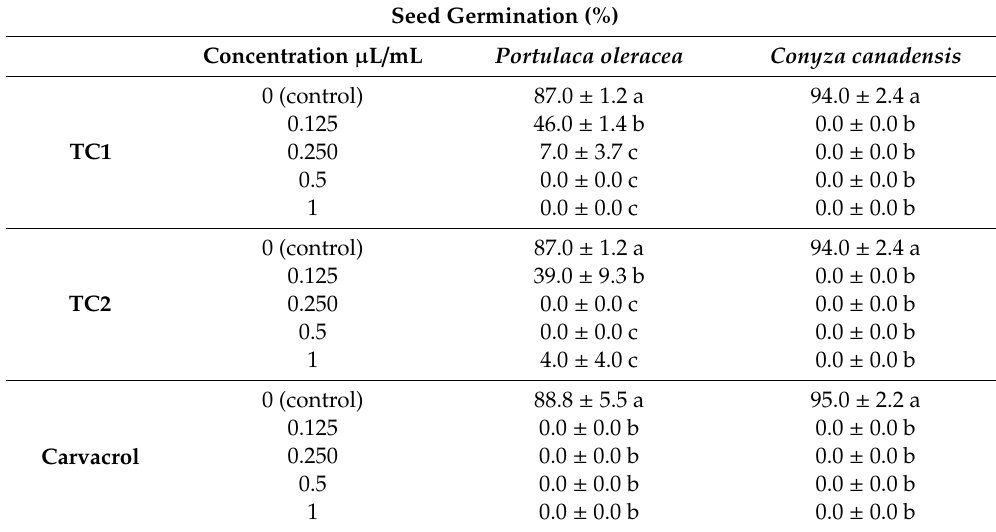
Table 2. Phytotoxic e ff ects of Thymbra capitata EOs obtained from plants at blooming (TC1) and vegetative stage (TC2) and carvacrol, on Portulaca oleracea and Erigeron canadensis seed